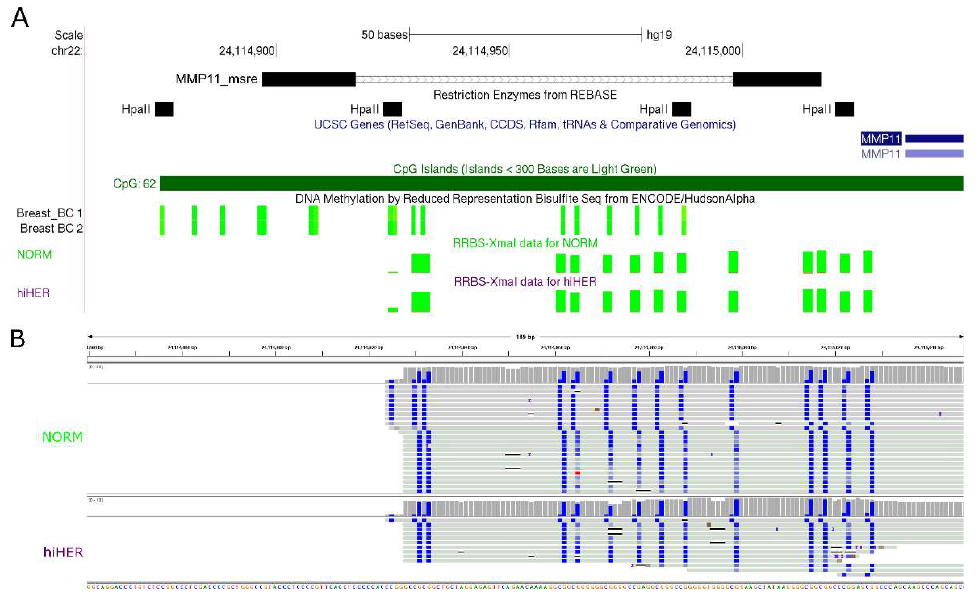
Figure 3. Methylation of a fragment of the MMP11 gene promoter assessed by MSRE-PCR and reduced representation bisulfite sequencing (RRBS). ( A ) MMP11_msre, an MSRE-PCR product; primers are black rectangles and the insert is a tiny line. Breast_BC1 and Breast_BC2, ENCODE RRBS results: green is for non-methylated CpGs. NORM, XmaI-RRBS results for normal breast tissues. hiHER, XmaI-RRBS results for HER-positive breast tumors of the CpG island hypermethylated subtype. Green is for non-methylated CpGs. ( B ) Examples of clonal bisulfite sequences obtained by by XmaI-RRBS. NORM, one of the normal breast tissue samples. hiHER, one of the HER-positive breast tumors of the CpG island hypermethylated subtype. Blue is for non-methylated CpGs.